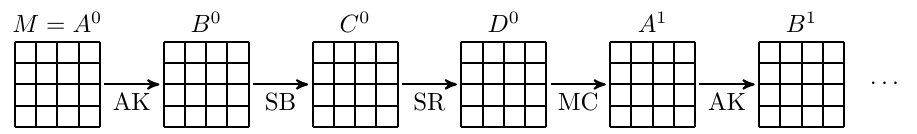
Figure 1: Pilsung states after the different operations and rounds. AK, SB, SR, and MC stand for Add-Round-Key, Sub-Bytes, Shift-Rows, and Mix-Columns,